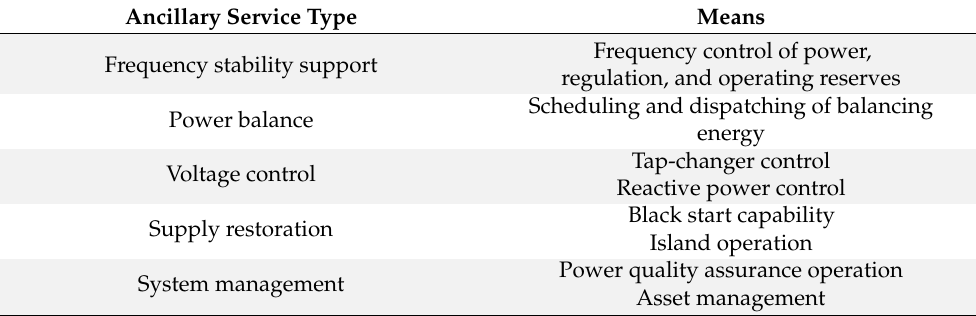
Table 1. Ancillary